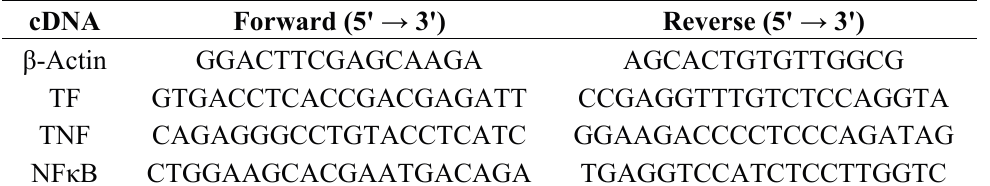
Table 2. Gene specific primer sequences for RT-PCR a